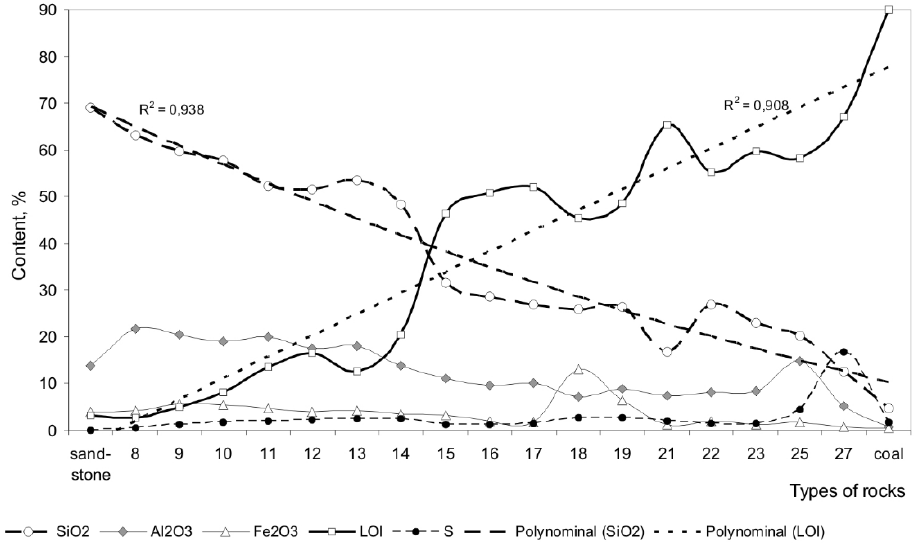
Figure 8. Behavior of the main chemical components in the process of natural low-temperature pyrolysis of coal-bearing deposits. Types of rocks: sandstone and coal—the most important protolites of technogenic-redeposited deposits; 8–12—low-temperature formed red rocks of metamorphic mass; 13–14—grey-colored coal bearing deposits of heat zone; 15–16—lean coal-bearing black deposits of activated zone; 17–19, 21–23, 25, 27—variegated products of enriched pyrolysis zone.